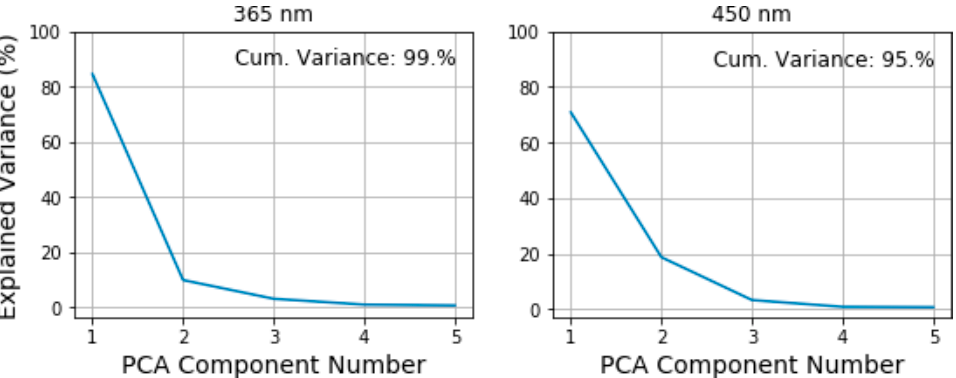
Figure 5. Example of percentage of explained variance at the excitation channel of 365 nm ( left ) and 450 nm ( right ) achieved by PCA.